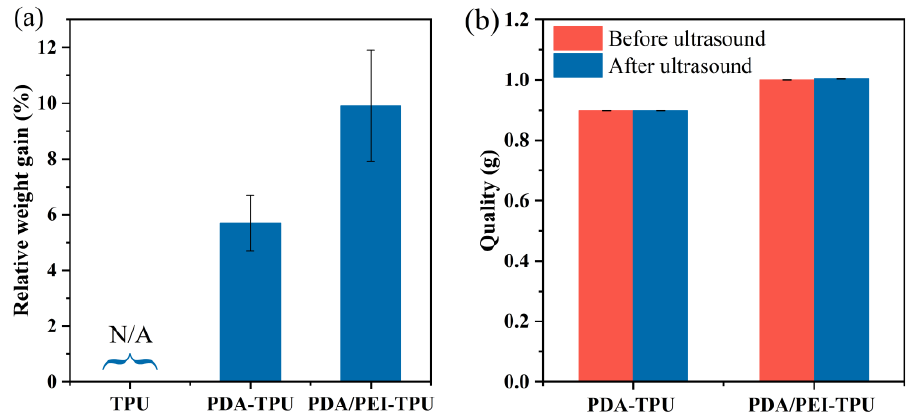
Figure 2. ( a ) The grafted yield of the membranes after modification. ( b ) Stability of modified membranes after ultrasound.